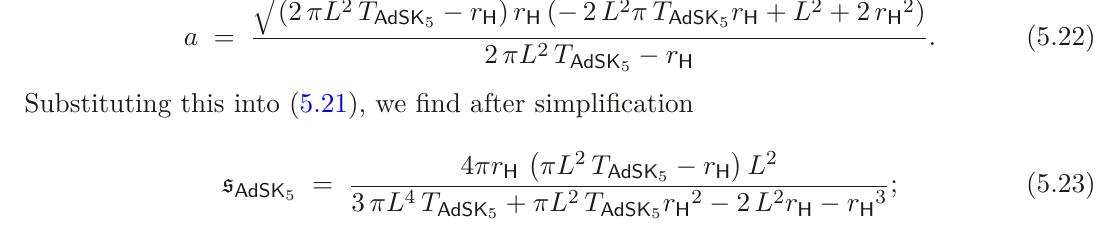
JHEP02(2023)072